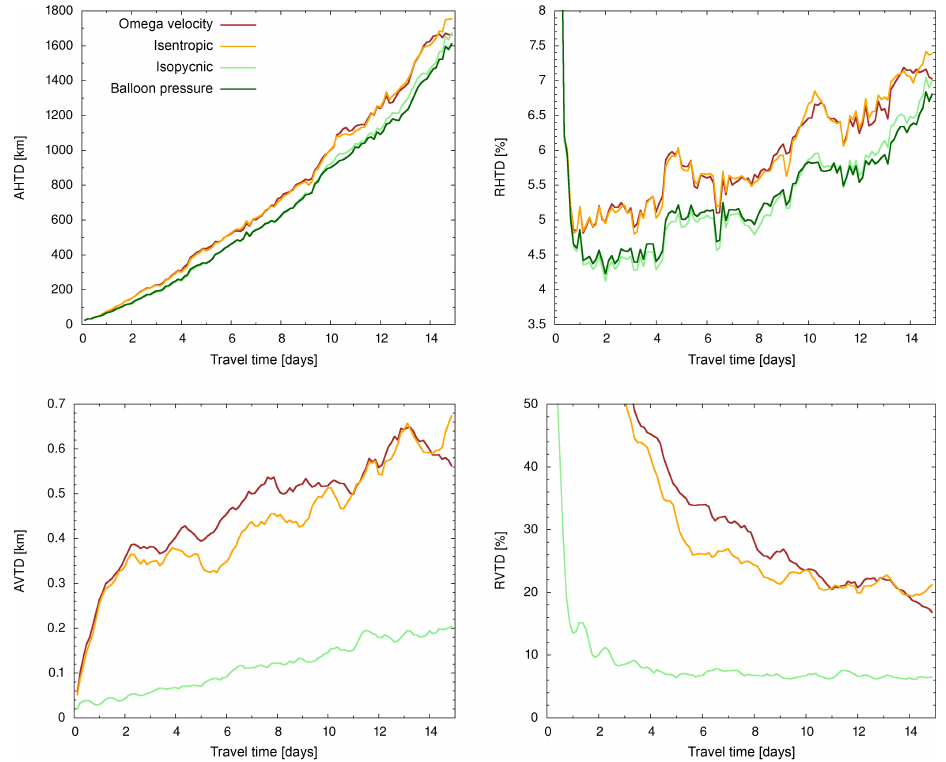
Figure 7. Transport deviations of simulated and observed balloon trajectories for different types of vertical motion. Trajectories were calcu- lated with ERA-Interim horizontal winds. The analysis is based on 104 samples of 15-day trajectories from the Concordiasi